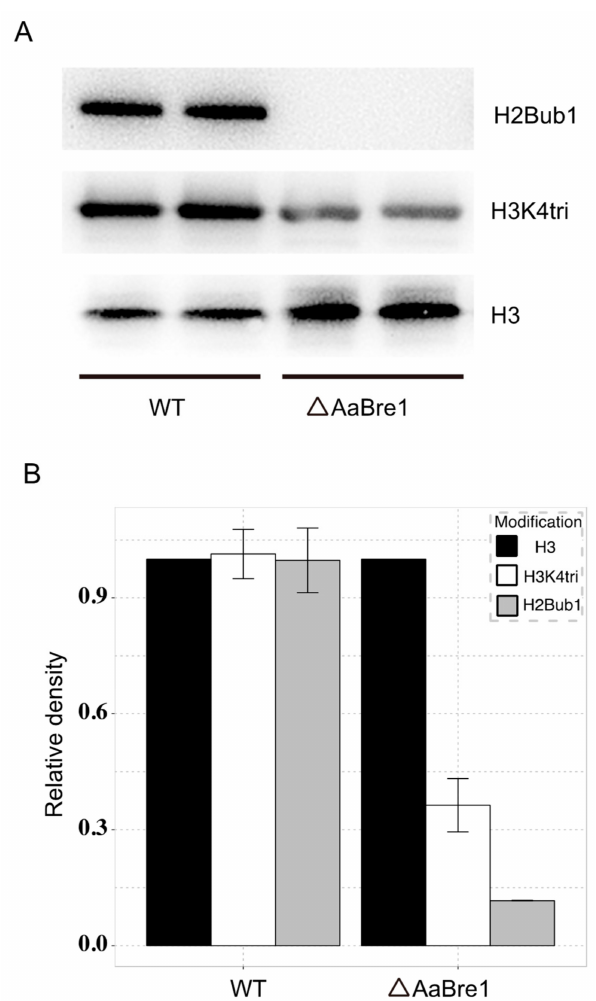
Figure 5. AaBre1 regulates H2B monoubiquitination and H3K4 trimethylation. ( A ) Western blot